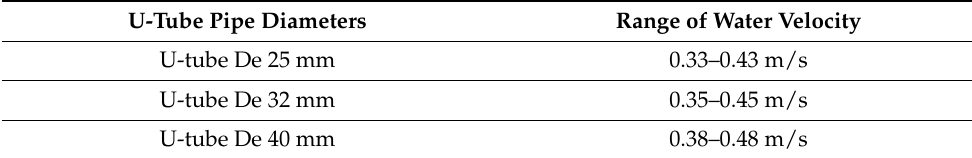
Table 5. Acceptable ranges of water velocity in varying vertical single U-tube